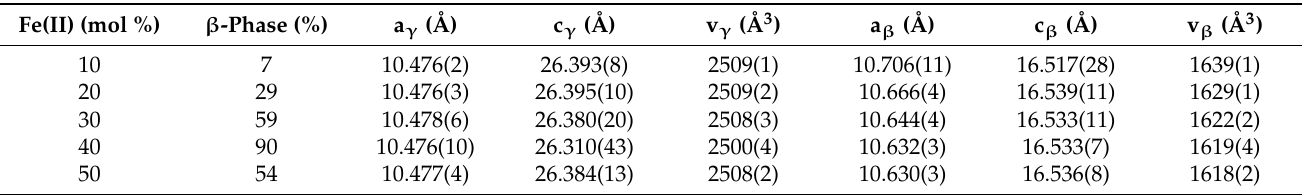
Table 8. Reitveld refinements for co-crystallizations of [Fe(bpy) 3 ](PF 6 ) 2 with [Zn(bpy) 3 ](PF 6 ) 2 .